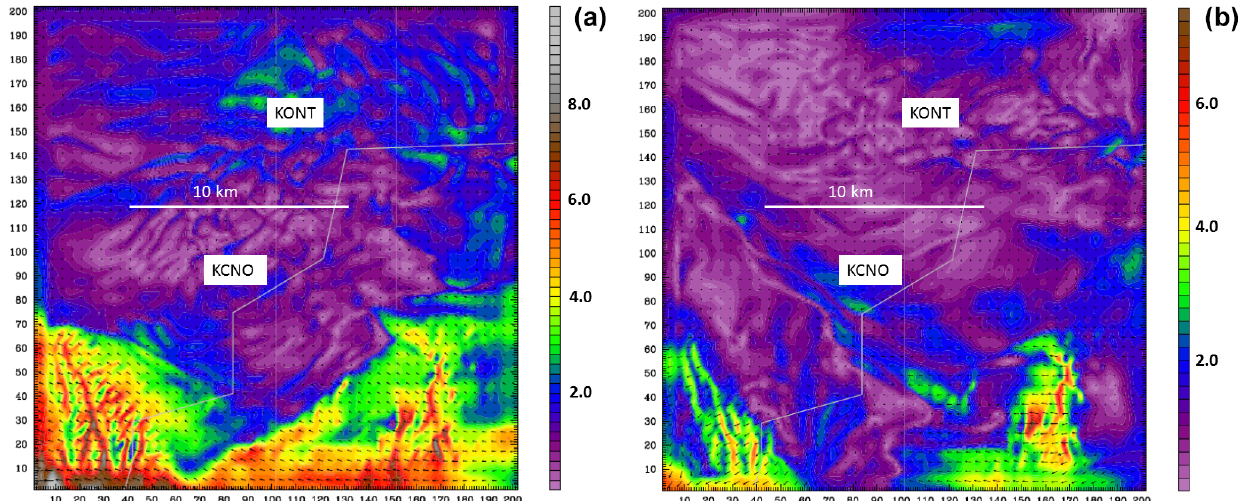
Figure 9. Mean horizontal wind field (in ms − 1 ) in the first level of the domain at 111m resolution simulated by WRF-LES for 15 Jan- uary (a) , and 16 January 2015 (b) at 18:00UTC. High wind speeds were simulated over the hills (southern part of the domain) whereas convective rolls, corresponding to organized turbulent eddies, are visible in the middle of the domain (i.e., over the feedlots of Chino), high- lighting the importance of turbulent structures in representing the observed horizontal gradients of CH 4 concentrations. The locations of the Chino (KCNO) and Ontario (KONT) airports and the counties border (white line) are indicated.